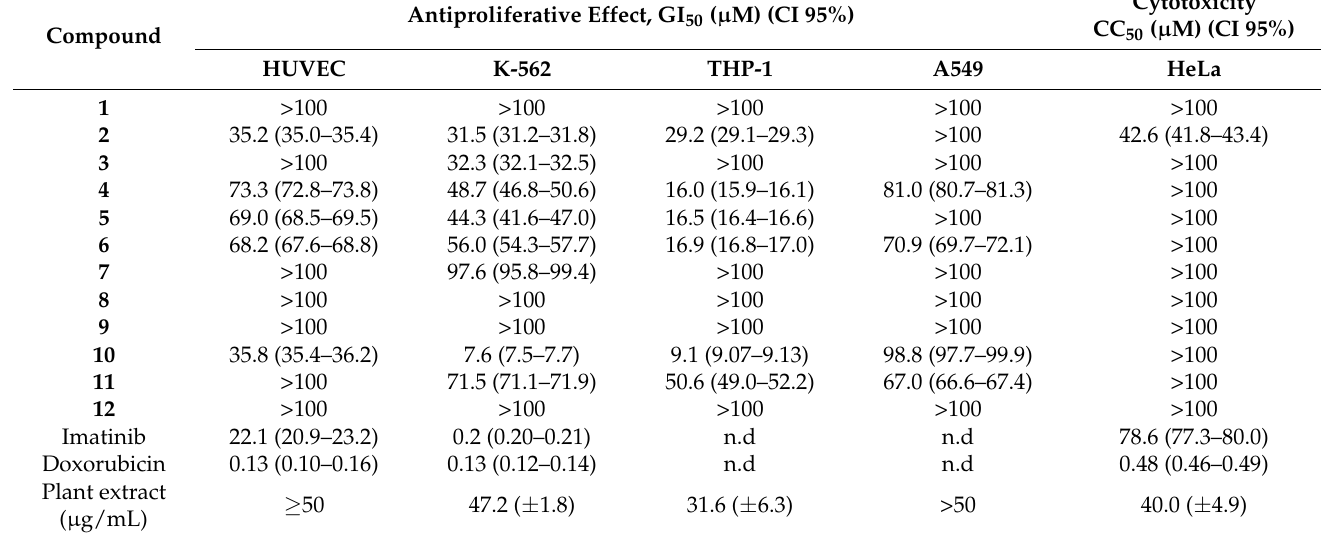
Table 4. Antiproliferative and cytotoxic activity of the plant extract and isolated compounds from I. tenuifolia . Antiproliferative Effect, GI 50 ( µ M) (CI Compound